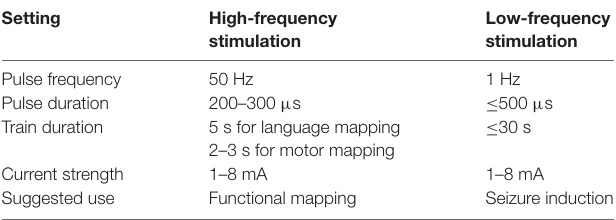
TABLE 2 | Suggested protocol for electrical stimulation mapping with stereo-EEG based on practice at the Cincinnati Children’s Hospital.